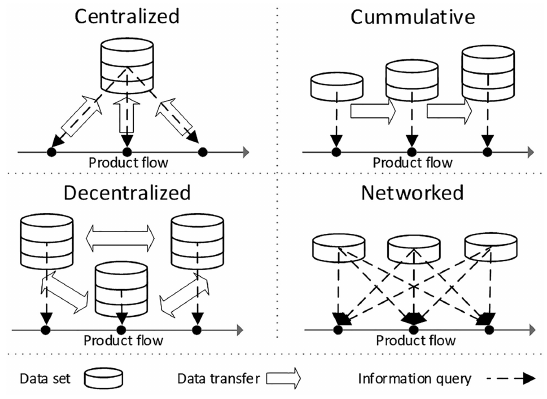
Figure 1. Distribution of traceability